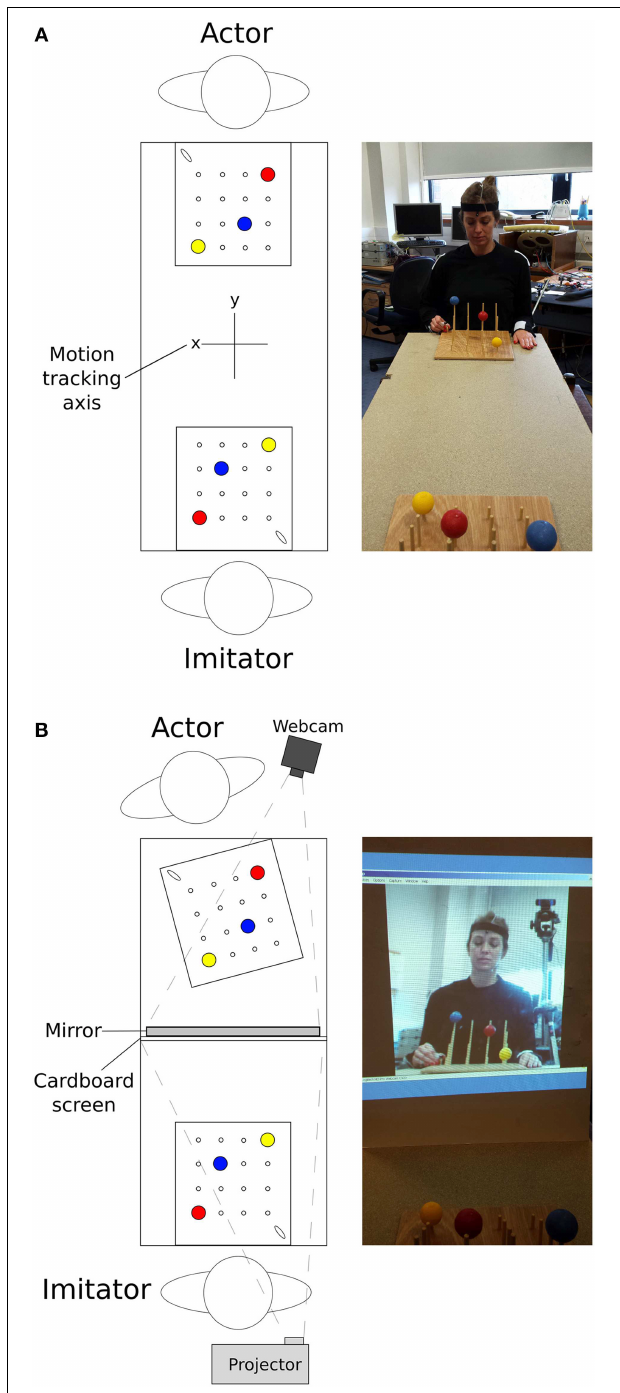
FIGURE 2 | Top-down view of the experimental set-up, along with an image of the approximate actor point of view for (A) face-to-face conditions and (B) video conditions; N.B. motion tracking axis in (B) is the same as in (A).